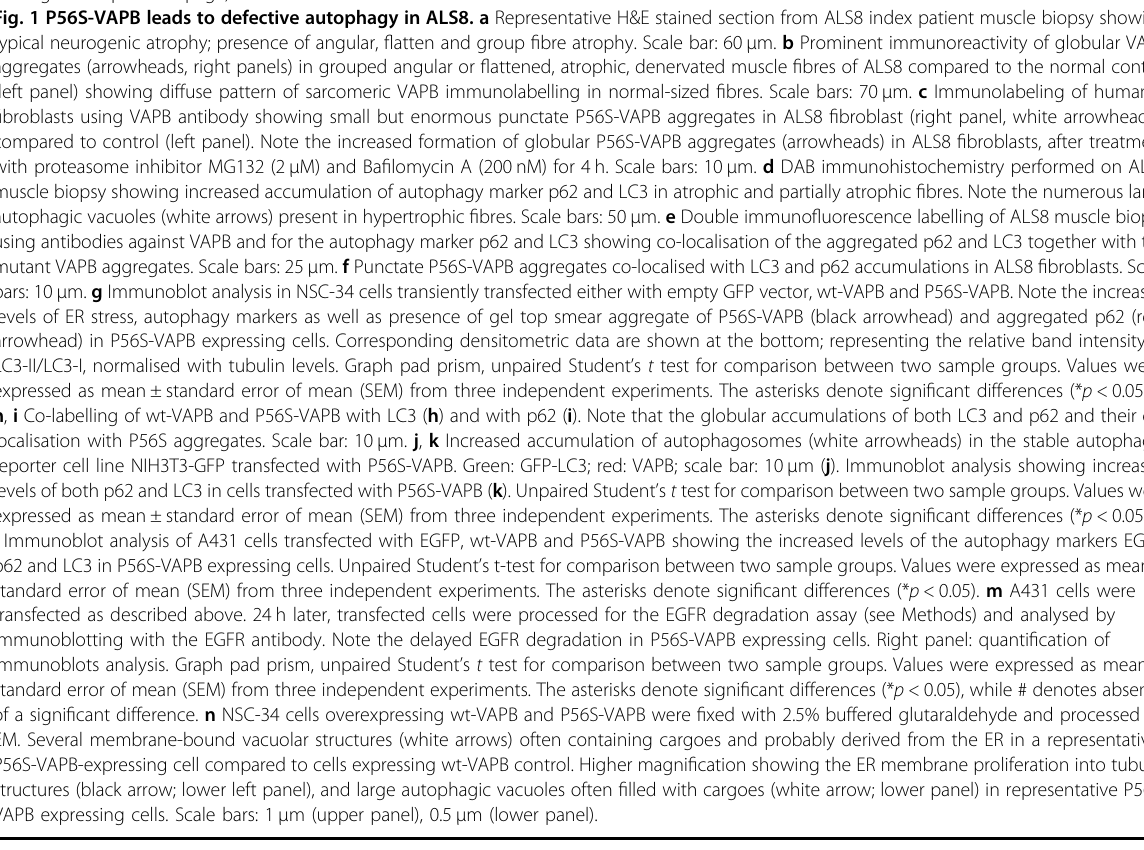
showing prominent accumulations of numerous autop- hagic vacuoles (white arrows) which also sequestered cellular components/cargoes (Fig. 1n). These changes were accompanied by the cytoplasmic accumulation of tubular structures (black arrow), probably re fl ecting ER proliferation (Fig. 1n).